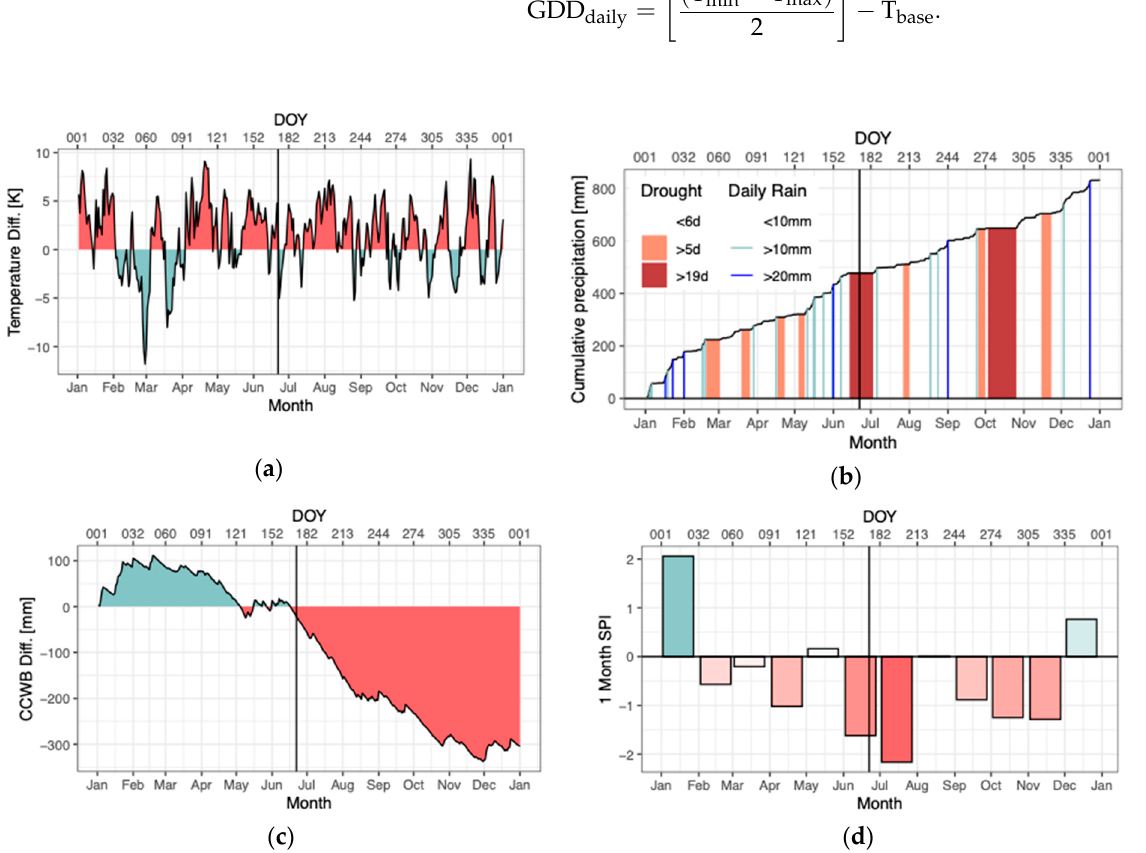
Figure 3. Meteorological and hydrological anomalies in the year 2018 for the low elevation with vertical lines representing the timing of the summer solstice. ( a ) Daily difference of air temperature to long-term mean; ( b ) daily cumulative precipitation sum with underlying rain free periods and daily heavy rain events; ( c ) daily difference of cumulative climatic water balance (CCWB) to long-term mean; ( d ) monthly SPI-values.